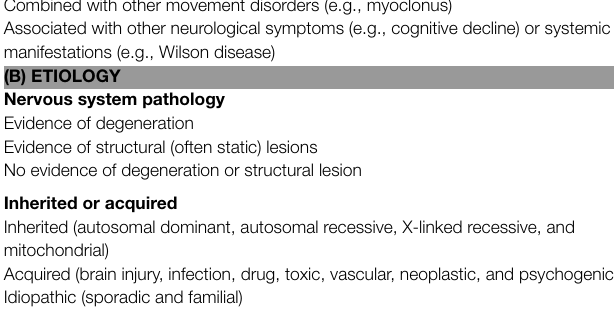
TABLE 1 | Classification of dystonia (1) . (A) CLINICAL CHARACTERISTICS OF DYSTONIA Age of onset (infancy, childhood, adolescence, and early/late adulthood) Body distribution Focal (only one body region is affected. e.g., blepharospasm) Segmental (two or more contiguous body regions are affected) Multifocal (two non-contiguous or more – contiguous or not – body regions are involved) Hemidystonia (more body regions restricted to one body side are involved) Generalized (involvement of the trunk and at least two other sites, including leg or not) Temporal pattern Course of disease (static or progressive) Variability Persistent (appears to approximately the same extent throughout the day) Diurnal (recognizable circadian variations in occurrence, severity and